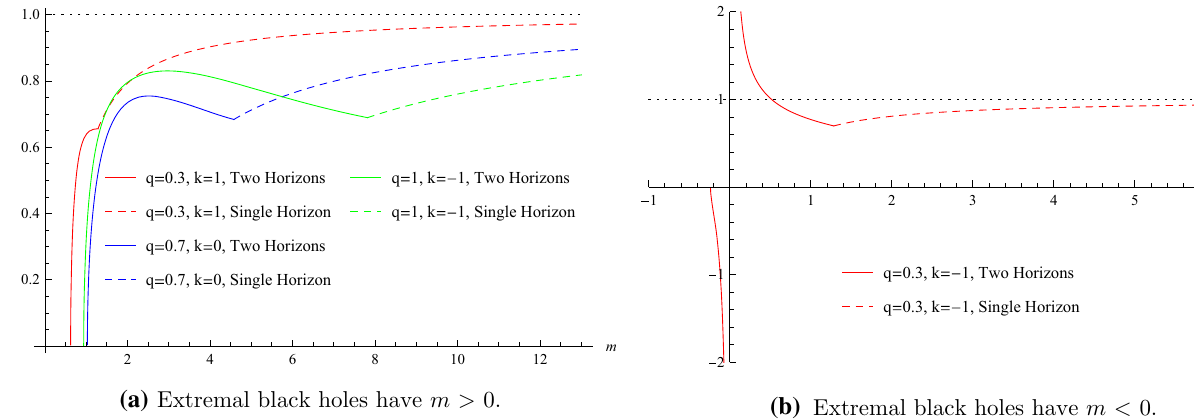
Fig. 5 The rate of the complexity in CA duality divided by the Lloyd bound, ˜ R A . Here we take d = 3, L = 1 and β = 10